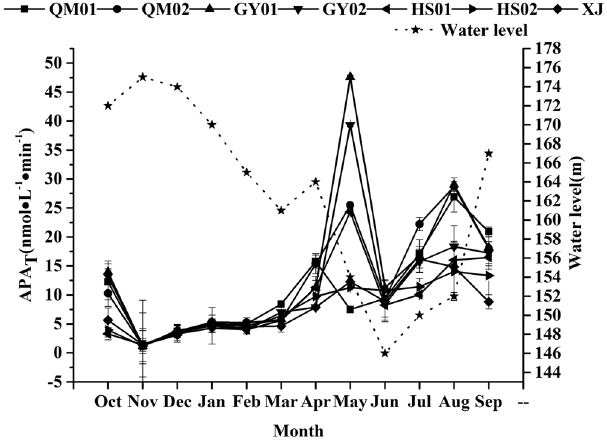
Figure 1. Monthly variations of the total APA concentrations in different sample sites and water level in the Xiaojiang